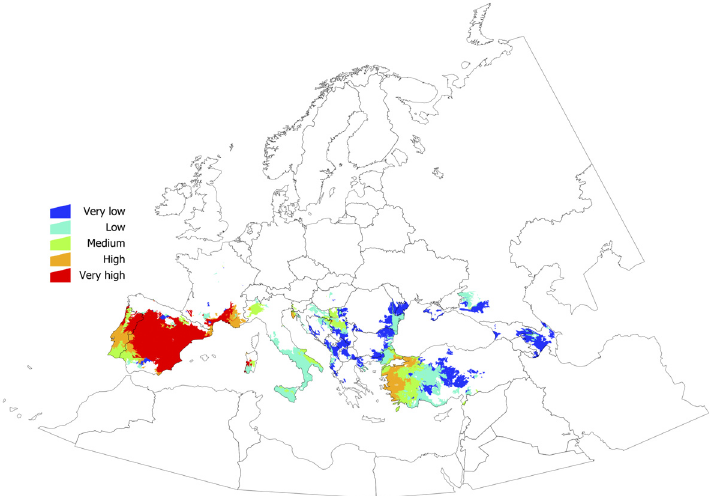
Fig 5. Evaluation of the target territory based on the trend of the change in the tick ’ s physiological processes over the period of study (exposure) and the density of domestic ruminants as hosts for adults (vulnerability). The map is intended to indicate the candidate areas where active surveys should be performed to check for changes in the tick ’ s population